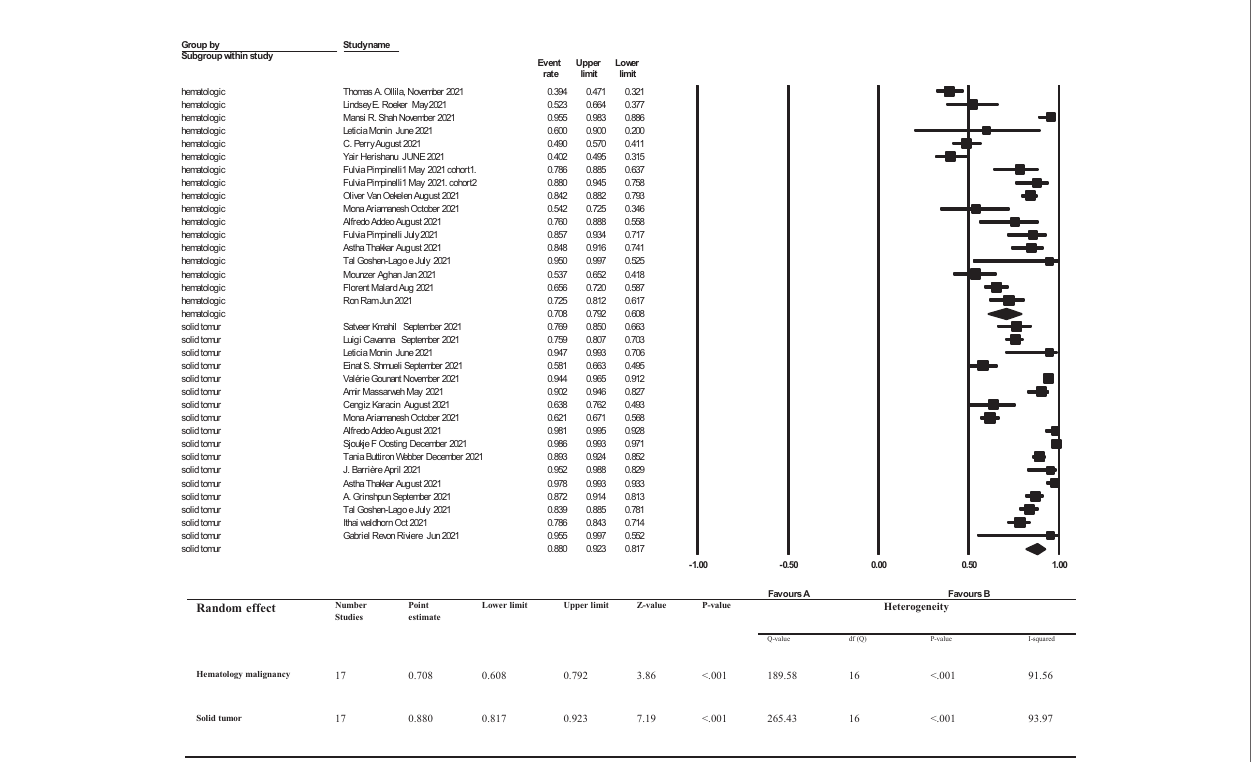
FIGURE 4 | subgroup analysis of Seroconversion rate after more than 2 weeks of receiving second dose of COVID-19 vaccine in cancer patients. Addeo et al. (25), Agha et al. (34), Ariamanesh et al. (7), Barrière et al. (29), Cavanna et al. (15), Goshen-Lago et al. (32), Gounant et al. (18), Grinshpun et al. (31), Herishanu et al. (20), Karacin et al. (24), Mahil et al. (11), Malard et al. (36), Massarweh et al. (21), Monin et al. (16), Ollila et al. (12), Oosting et al. (27), Perry et al. (19), Pimpinelli et al. (22), Pimpinelli et al. (26), Ram et al. (37), Revon-Riviere et al. (35), Roeker et al. (13), Shah et al. (14), Shmueli et al. (17), Thakkar et al. (30), van Oekelen et al. (23), Waldhorn et al. (33), Webber et al.